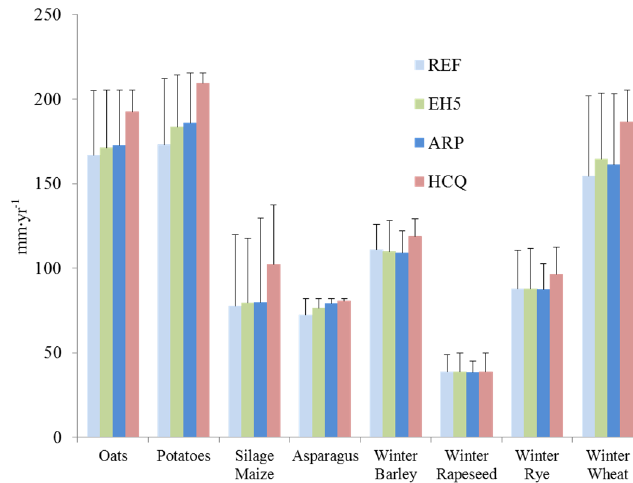
Figure 9. Average crop irrigation demands for several climate projections in the period 2018–2052 (bar: medians, whiskers: 10th percentile).